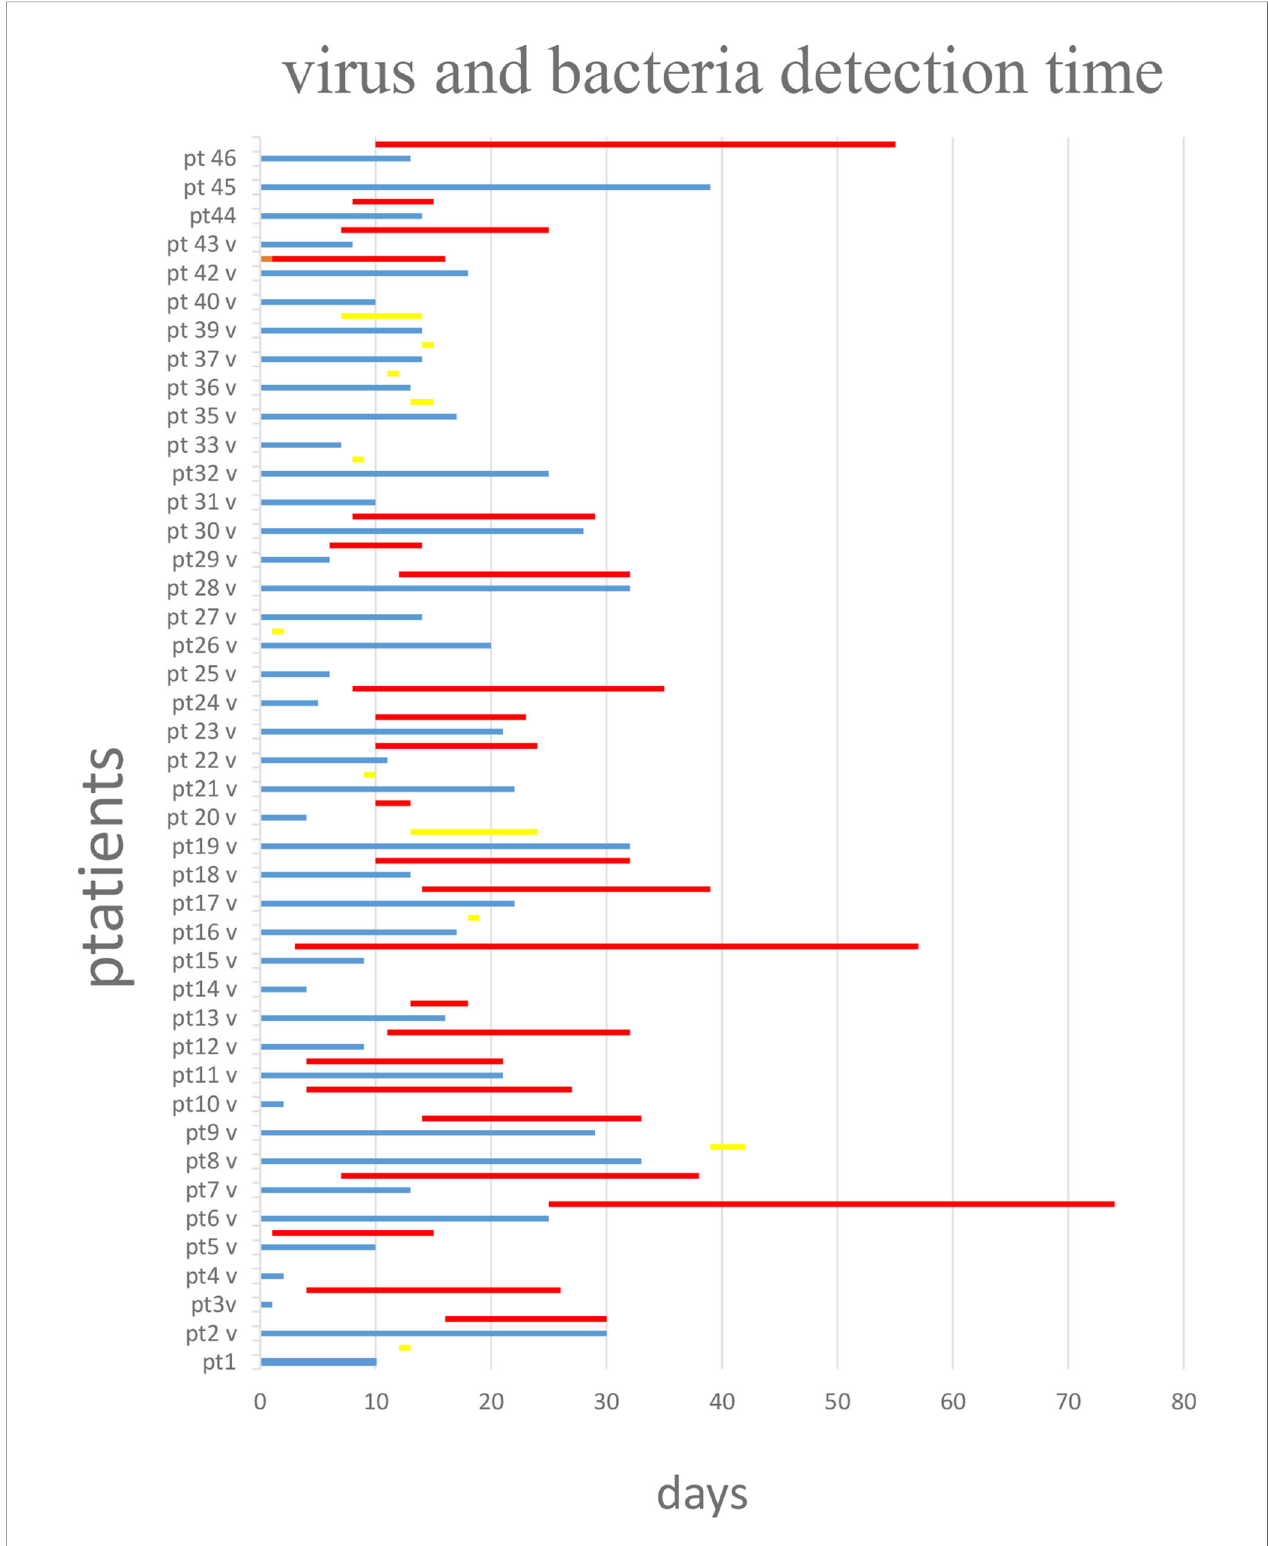
FIGURE 1 | Virus (blue lines) and bacteria (red line if high load, yellow line if in low load) detection over the time starting from day 0 that represent the admission in intensive care unit. Virus and bacteria were detected in the BA of the 43 patients with COVID-19 disease. Blue line: days of virus detection. Red line: days of bacteria detection in high load. Yellow line: days of bacteria detection in low